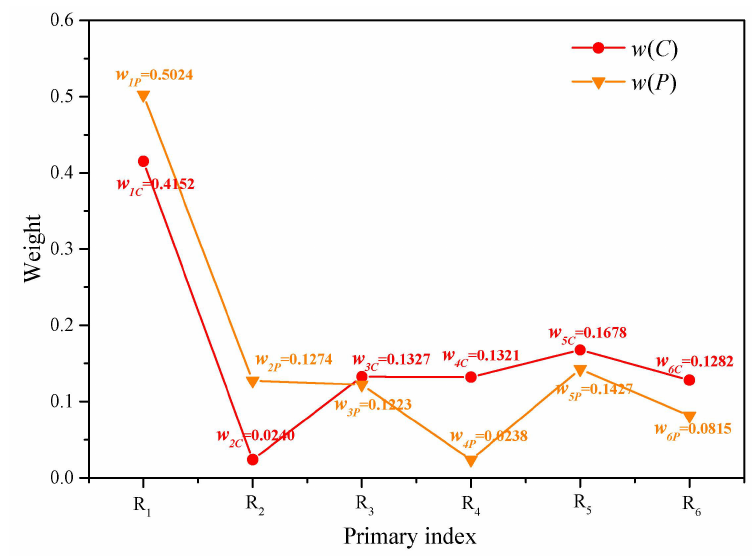
Figure 5. Weight analysis results of primary